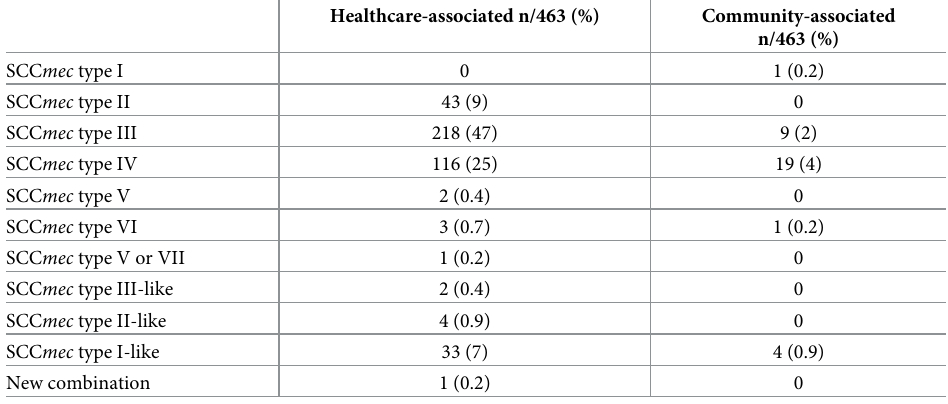
Table 1. Final SCC mec type distribution among MRSA isolates from 2013 to 2016 and its association between ori- gin of the infection (i.e. healthcare- or community associated). Healthcare-associated n/463 (%) Community-associated n/463